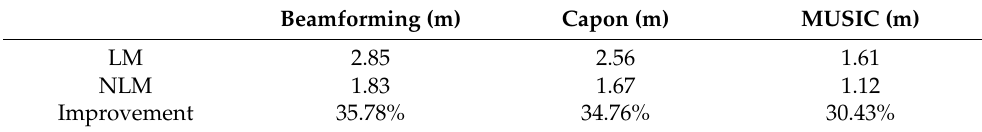
Figure 7. Underlying topography from LiDAR and TomoSAR: ( a , b ) are the LiDAR DTM; ( c ), ( e ), ( g ) are, respectively, the beamforming, Capon, and MUSIC results based on the LM method; and ( d ), ( f ), ( h ) are, respectively, the beamforming, Capon, and MUSIC results based on the NLM method. Table 6. Comparison of the RMSEs of the underlying topography inversion